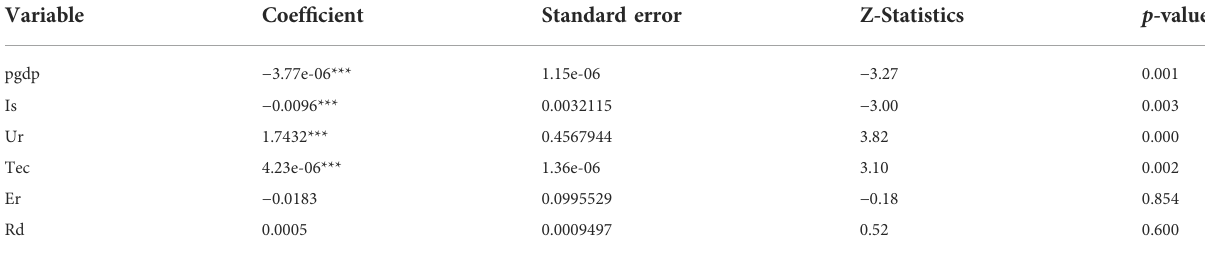
TABLE 4 Tobit regression